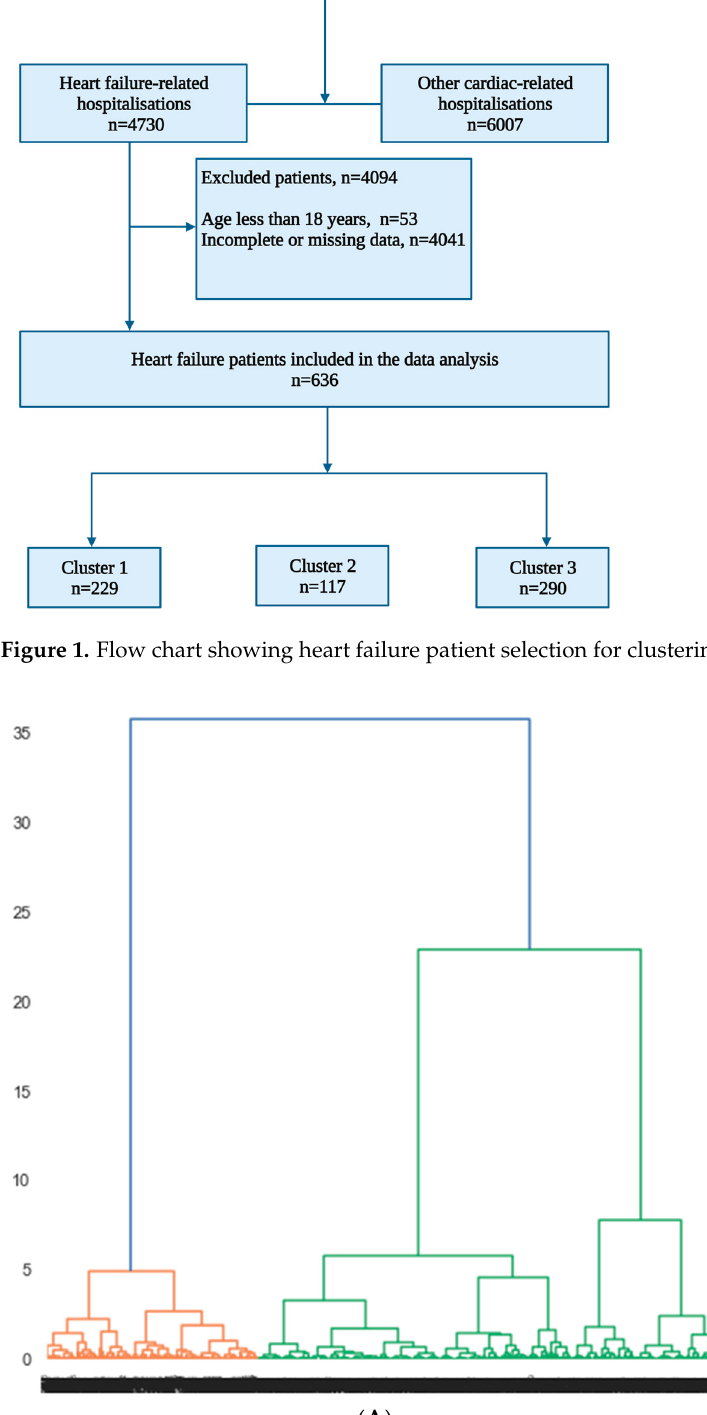
Data are presented as mean ± standard deviation for continuous features with a normal distribution, and median and interquartile ranges (IQR) (p25–p75) when the distribution is skewed. Categorical data are represented as absolute numbers and percentages. BP = blood pressure; eGFR = estimated glomerular filtration rate using the modification of diet in renal disease (MDRD) formula; HFrEF = heart failure with reduced ejection fraction (LVEF < 40%); HFmEF = heart failure with midrange ejection fraction (LVEF = 40–49%); HFpEF = heart failure with preserved ejection fraction (LVEF ≥ 50%); JVP = jugular venous pressure; LVEF = left ventricular ejection fraction; LVIDd = left ventric- ular internal diameter in end-diastole; LVIDs = left ventricular internal diameter in end-systole; S3 = third heart sound.